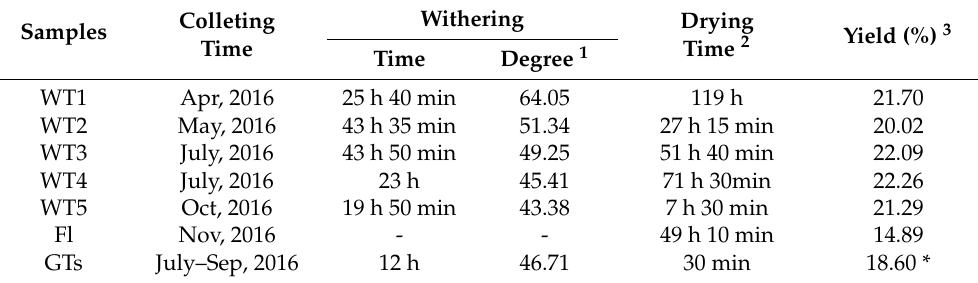
Table 1. Collecting time, withering time, withering degree, drying time, and yield of different “Pai- Mu-Tan” white tea (WT) and flowers (Fl) samples of Azorean Camellia sinensis var. assamica from Sete Cidades and of commercial green tea samples (GTs) of Azorean C. sinensis var. sinensis from Gorreana Tea